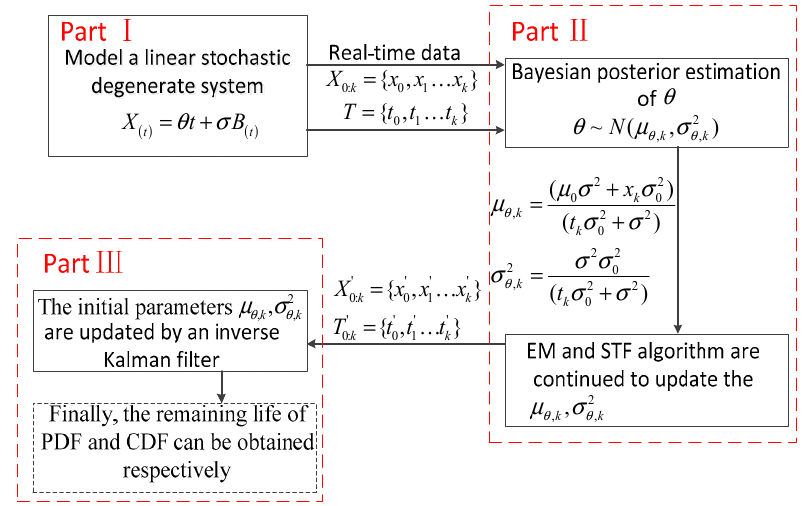
Figure 1. The flow chart of a linear stochastic degenerate system. EM: expectation maximization; STF: strong tracking filtering; PDF: probability density function; CDF: cumulative distribution function.